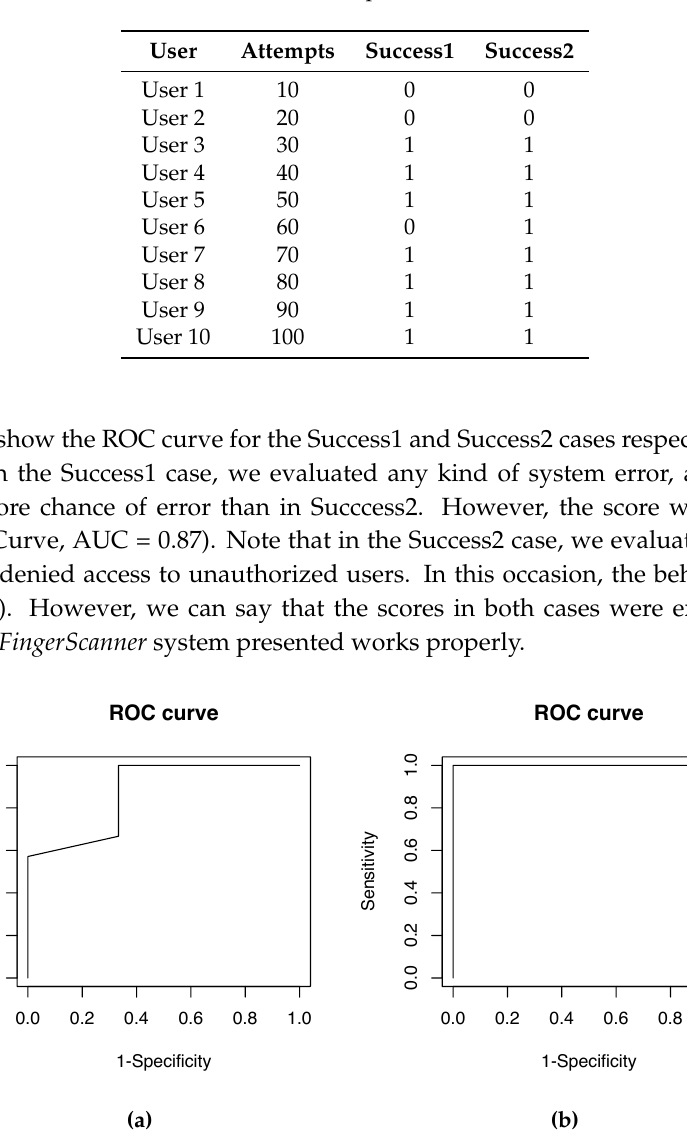
Table 8. User attempts and successes.